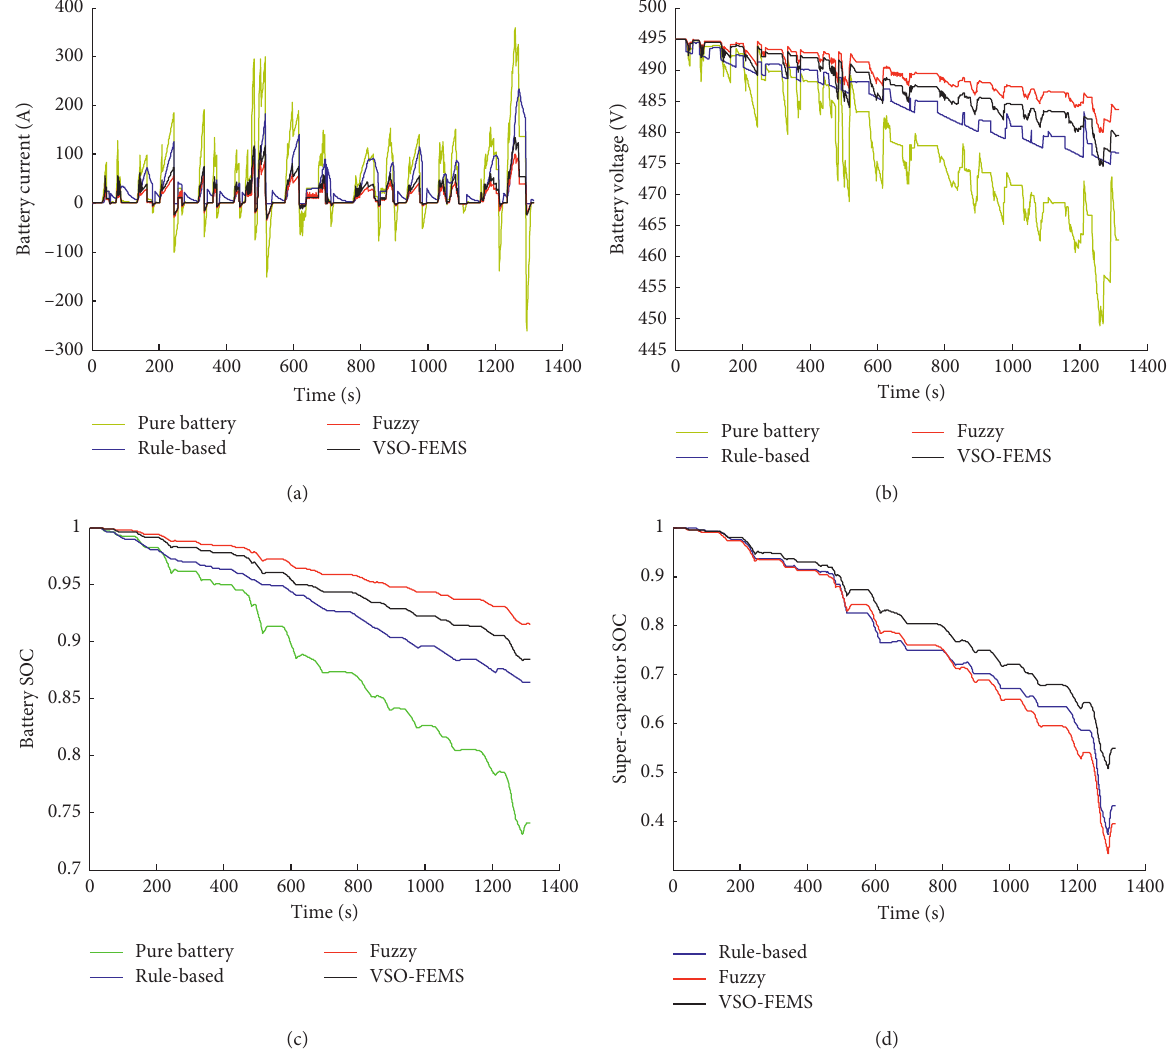
Figure 10: (a) Comparison of battery current. (b) Comparison of battery voltage. (c) Comparison of battery SOC. (d) Comparison of super- capacitor SOC.